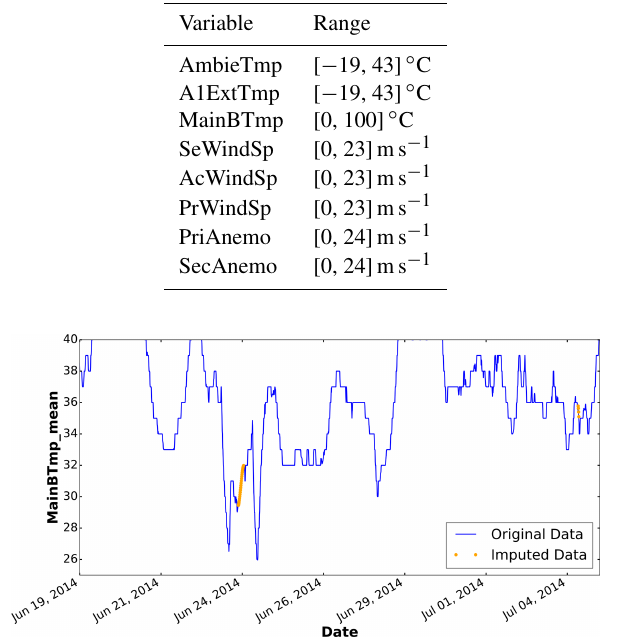
Figure 4. Imputation strategy used to fill missing values in the low- speed shaft temperature (given in degrees